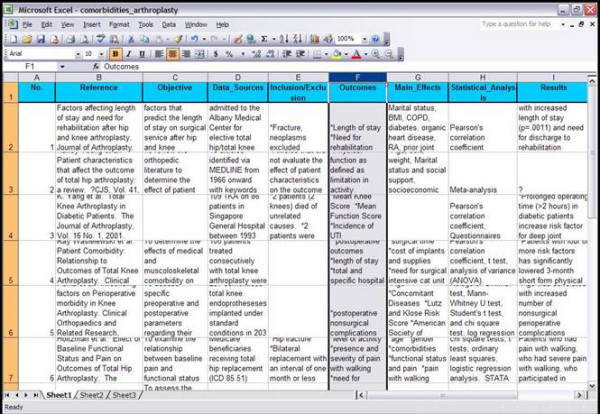
Literature Matrix